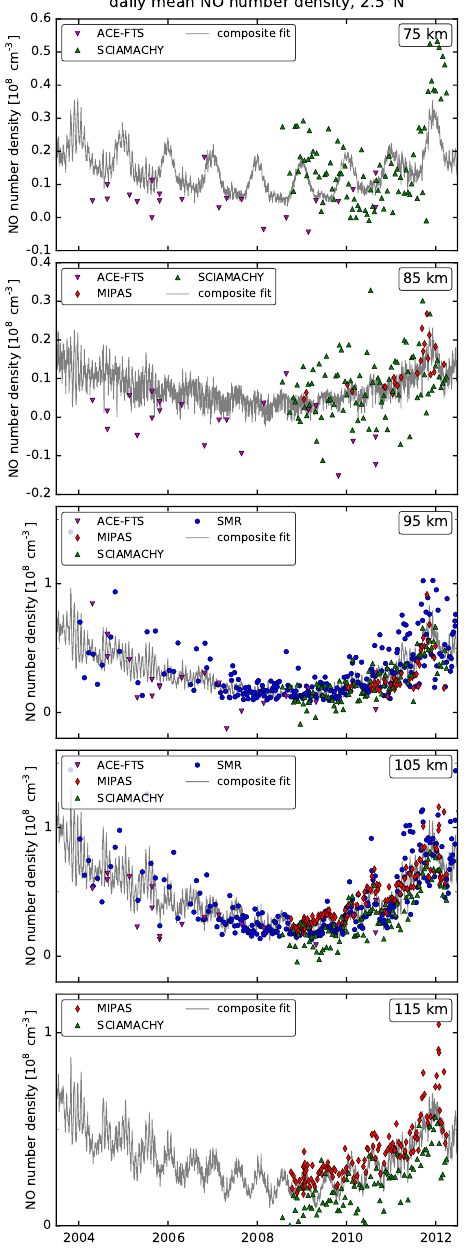
Figure C4. NO time series regression results at 2.5 ◦ N, for 75km, 85km, 95km, 105km, and 115km (from top to